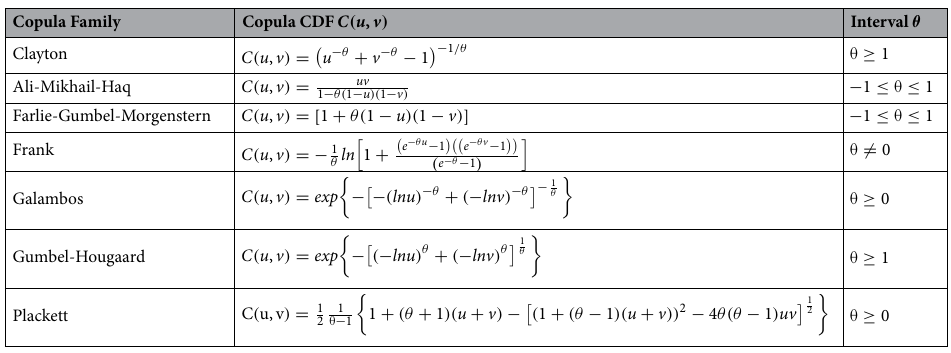
Table 3. The list of incorporated copulas and related